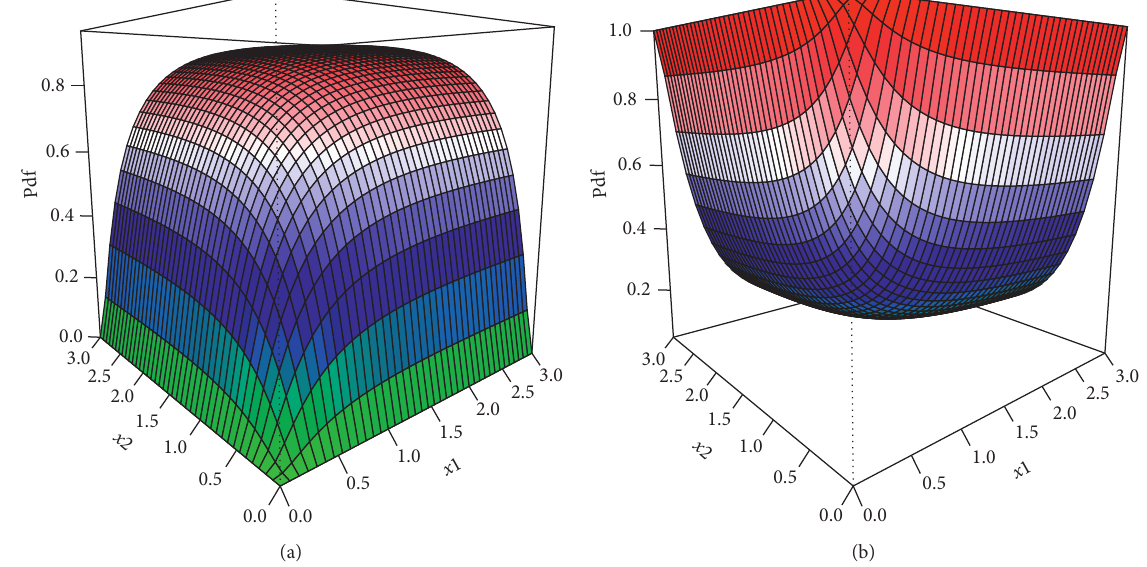
Figure 5: Plots for the cdf and sf of the FGMBL-Claim for α